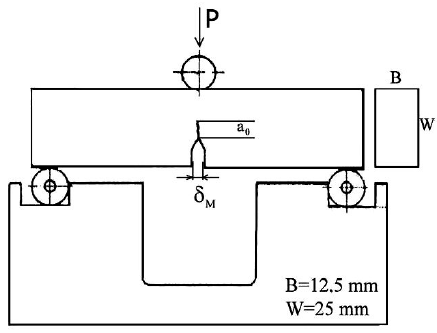
Figure 3. General diagram of the specimen loading in a three-point bending test.